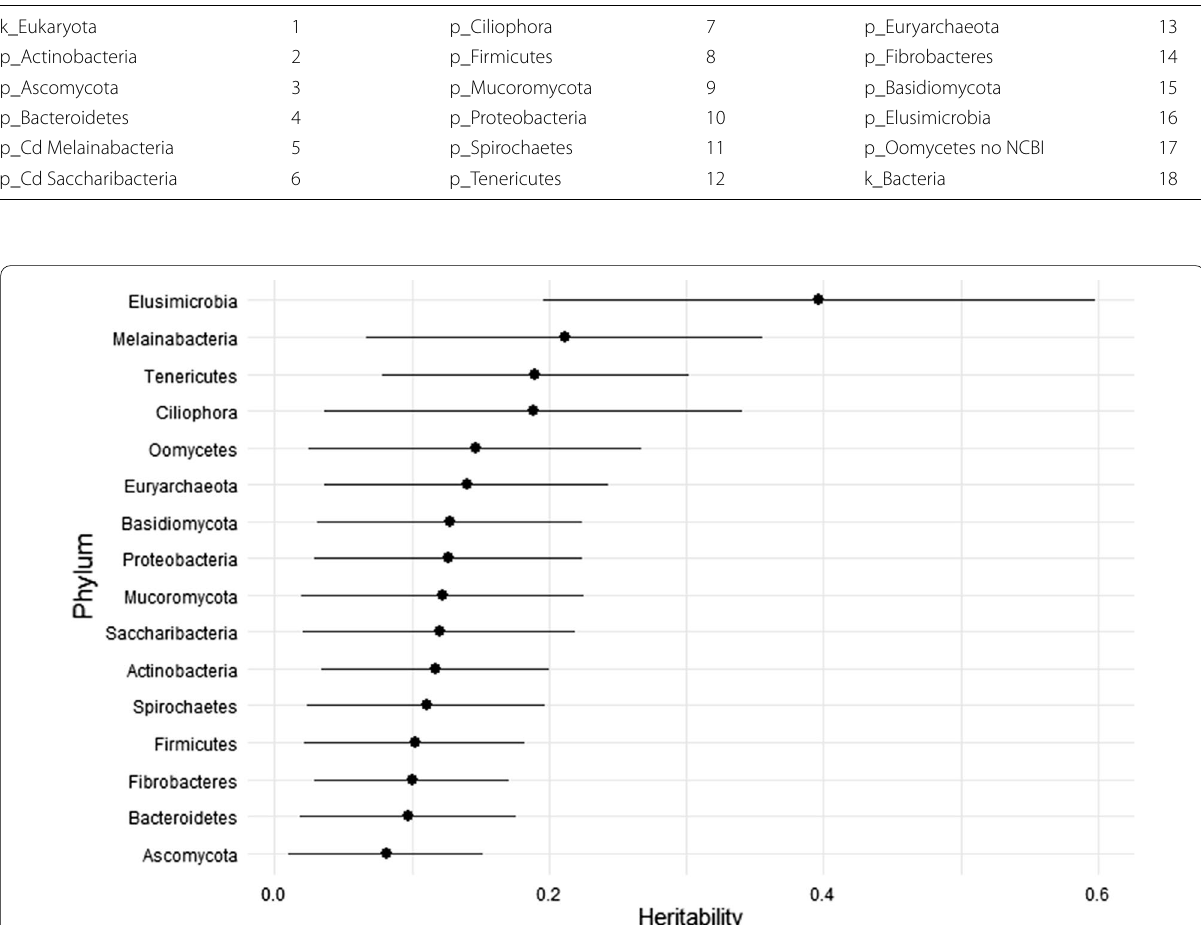
Fig. 7 Heritability of the phylum that share the larger amount of ARGs. The plot shows the heritability of these phyla and its standard